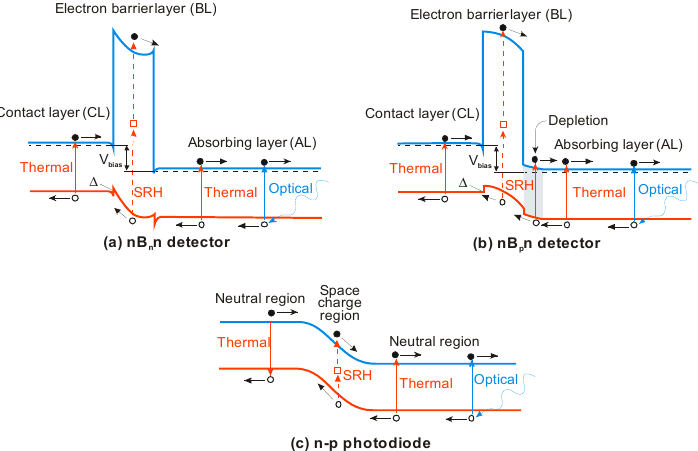
Figure 46. Bandgap diagram of nB n n ( a ) and nB p n ( b ) barrier detectors ( Δ -VBO) and p-n photodiode ( c ).